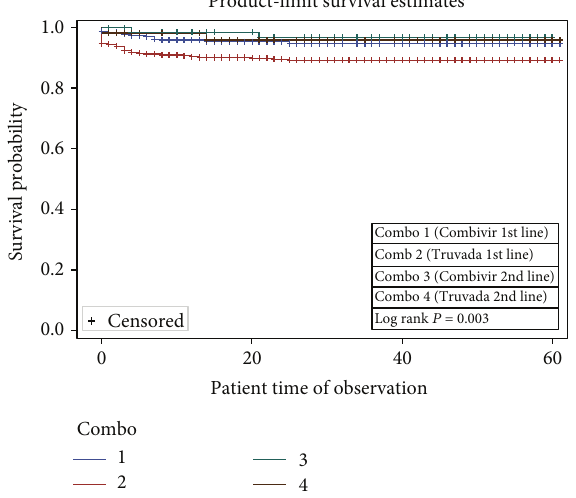
Figure 3: Survival curves based on regimen among patients in NCH.